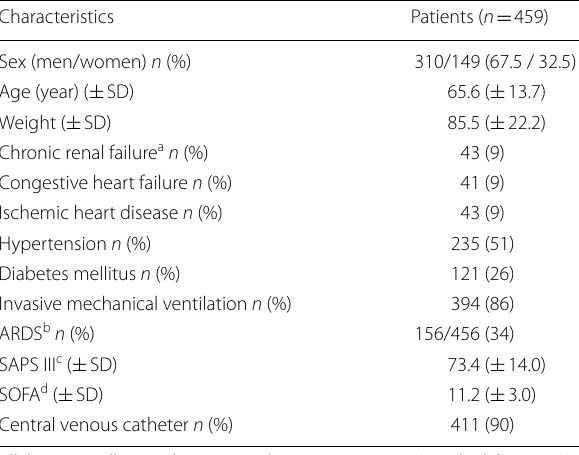
All data at enrollment. Plus–minus values are means a Chronic renal failure defined as eGFR < 60 ml/mn b ARDS: Berlin definition c The Simplified Acute Physiology Score (SAPS) III ranges from 0 to 146, with higher scores indicating more severe disease and a higher risk of death d The Sepsis ‐ related Organ Failure Assessment (SOFA) score ranges from 0 to 24, with higher scores indicating more severe organ failure